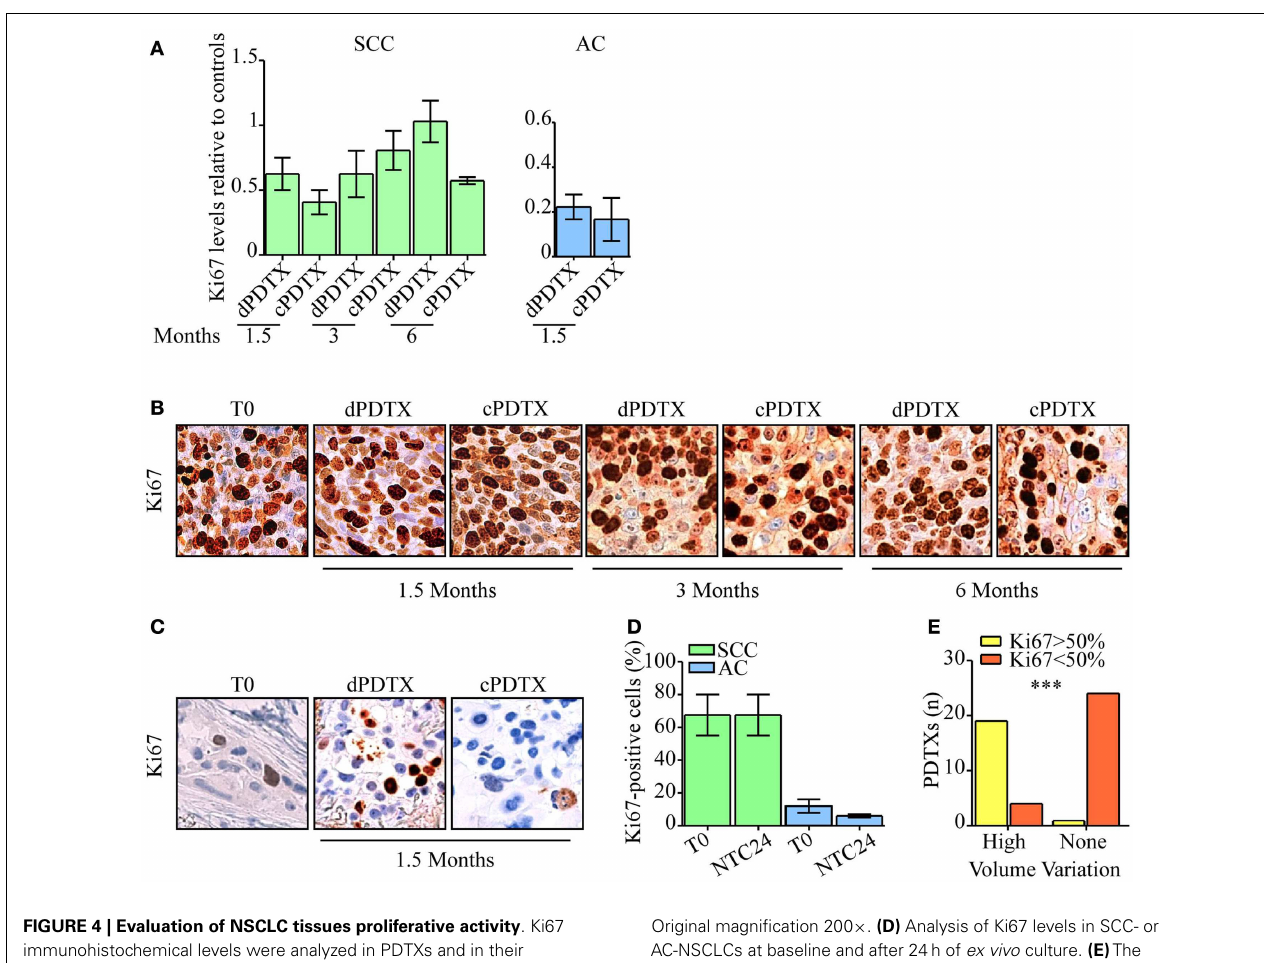
FIGURE 4 | Evaluation of NSCLC tissues proliferative activity . Ki67 immunohistochemical levels were analyzed in PDTXs and in their corresponding human cancer tissues. (A) Ki67 immunoreactivity is shown for SCC- and AC-PDTXs compared to their relative controls and at the indicated time points. (B,C) Representative images of Ki67 staining for SCC- (B) or AC5-NSCLC cases (C) and matched PDTXs.